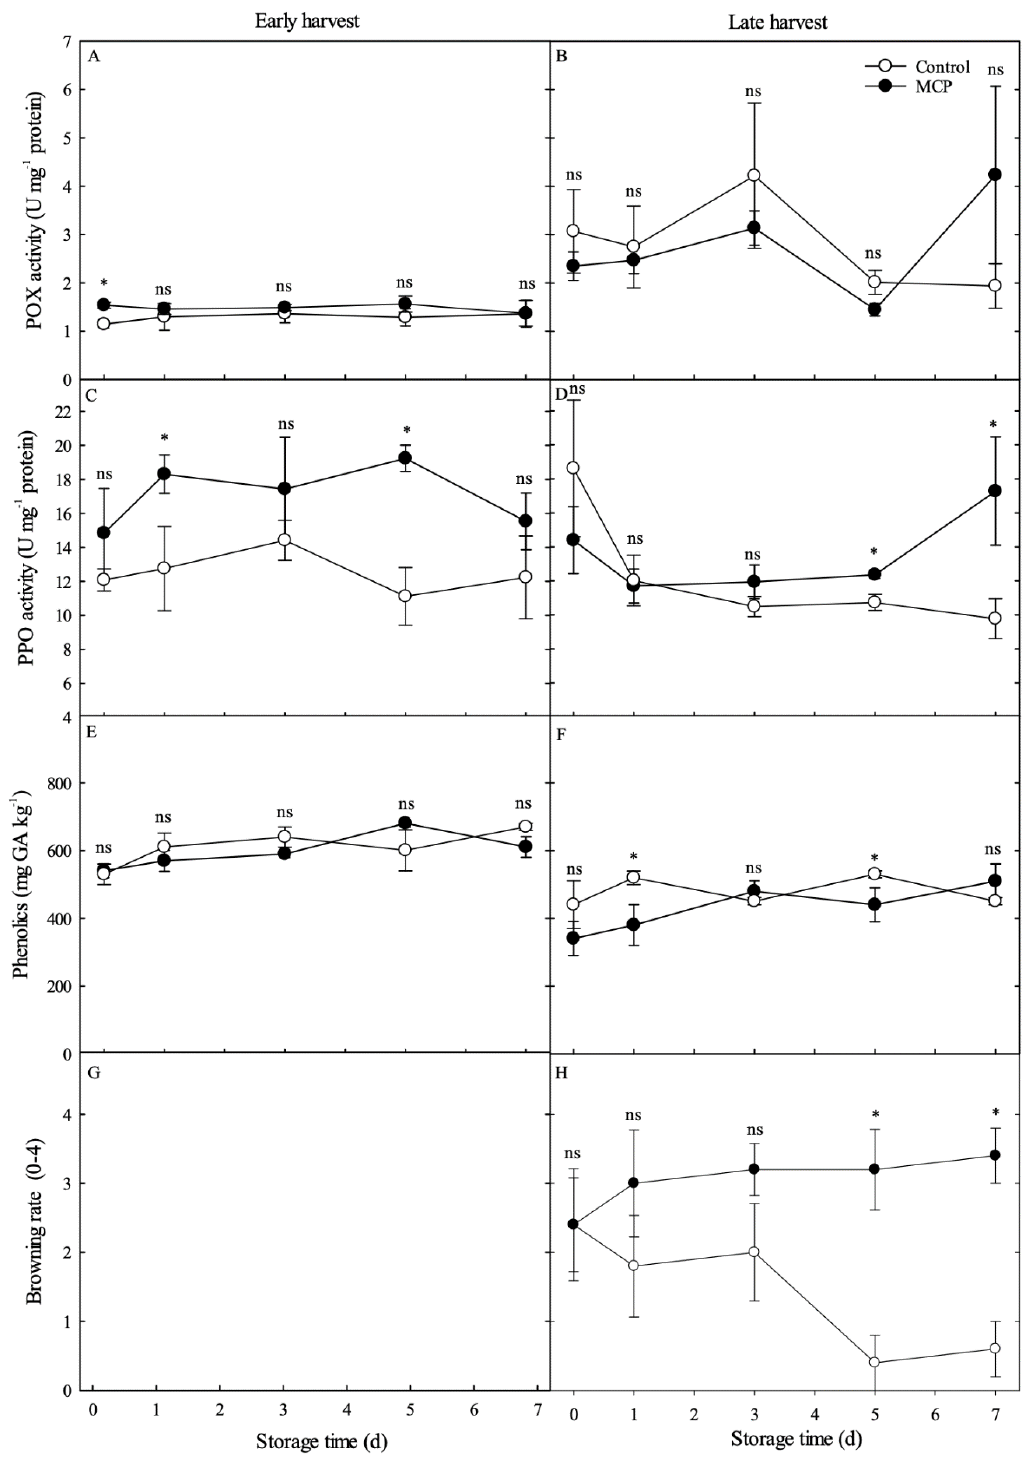
Figure 4. Peroxidase (POX) ( A , B ), PPO ( C , D ), total phenolic contents ( E , F ) and browning ( G , H ) of early and late-harvested ‘Empire’ apples and stored at 0.5 °C in air storage up to 7 months and evaluated for 7 days at 20 °C. Bars represent error of the means (SEM; n = 5), when larger than the dimension of the symbol. * Adjacent to each data point for each storage time indicates significant differences as determined by Duncan’s multiple range test at p ≤ 0.05; ns—not significantly different.